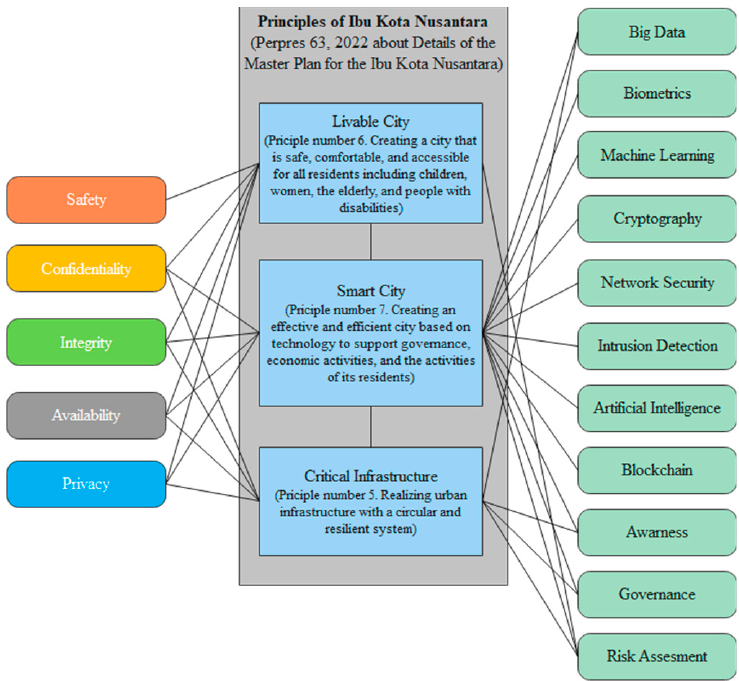
Figure 3. Relation of IKN Factors, Security Objective, and Technology.